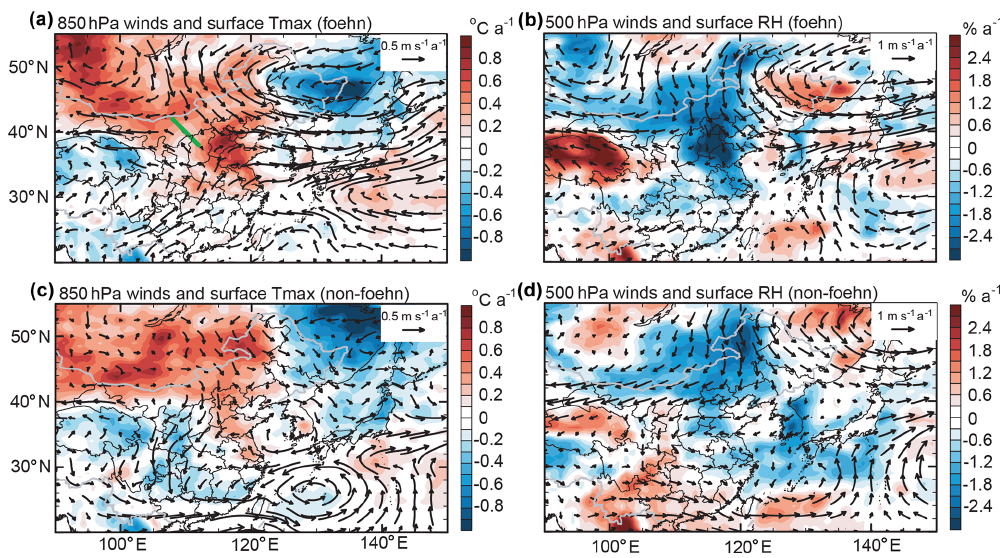
Figure 5. June mean trends in meteorological variables over 2013–2019 under foehn (a, b) and non-foehn (c, d) conditions. (a) Trends in 850hPa winds (ms − 1 a − 1 ) and surface daily maximum temperature ( ◦ Ca − 1 , shaded) under foehn conditions. (b) Trends in 500hPa winds (ms − 1 a − 1 ) and surface relative humidity (%a − 1 , shaded) under foehn conditions. Panels (c) and (d) are the same as panels (a) and (b) , respectively, but for non-foehn conditions. Data are from the MERRA-2 reanalysis, and trends are obtained by ordinary linear regression. Foehn conditions are diagnosed using a foehn index defined by the 850hPa northwesterly wind averaged along a section from 42 ◦ N, 108 ◦ E to 38 ◦ N, 112 ◦ E, shown using the green line in panel ( a ). The days with a positive (negative) foehn index are taken as foehn (non-foehn) conditions.